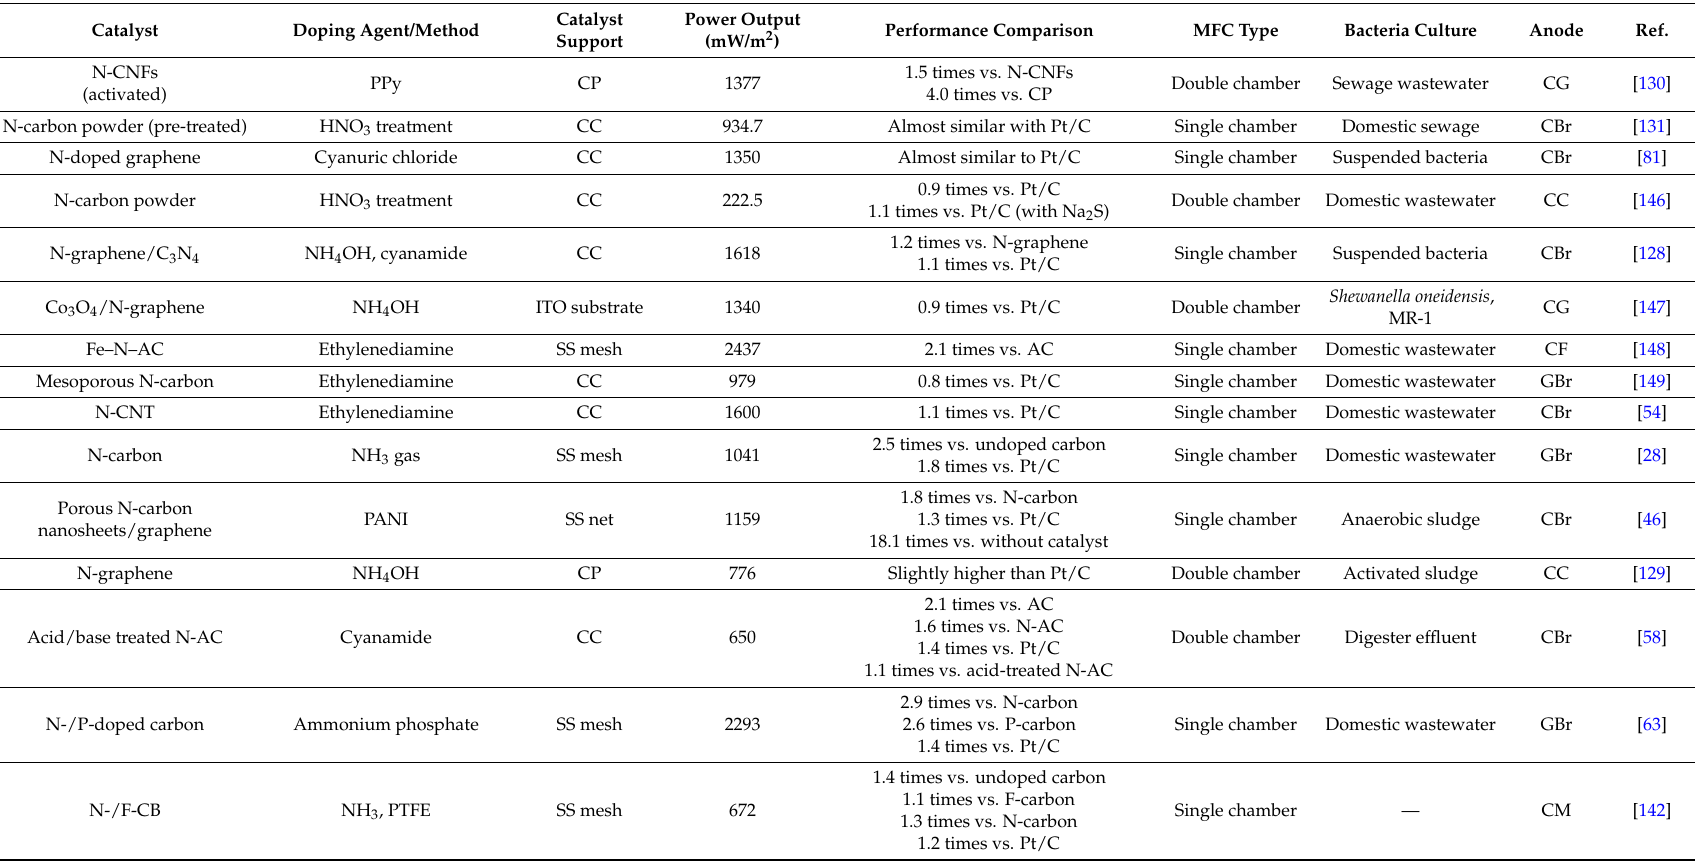
Table 6. Summary of the performance of different MFCs operated using different heteroatom-doped carbon materials as a